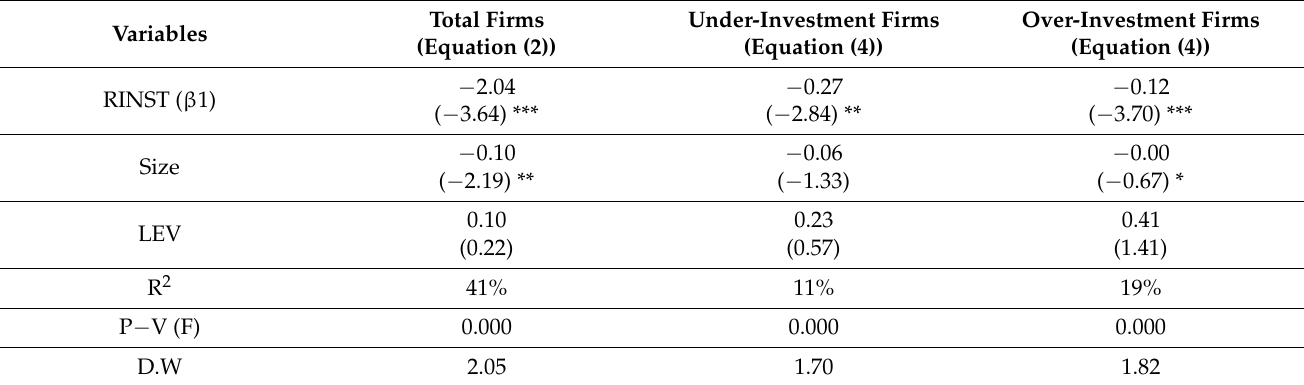
Table 5. Investment efficiency and institutional